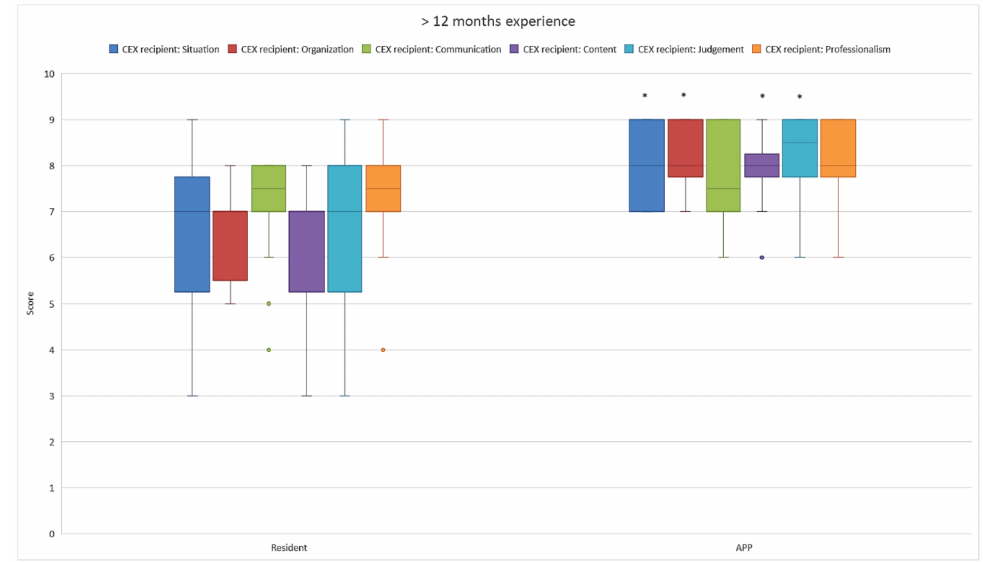
Figure 3. The handoff CEX recipient scores of MRs and APPs with more than 12 months experience. *: p <